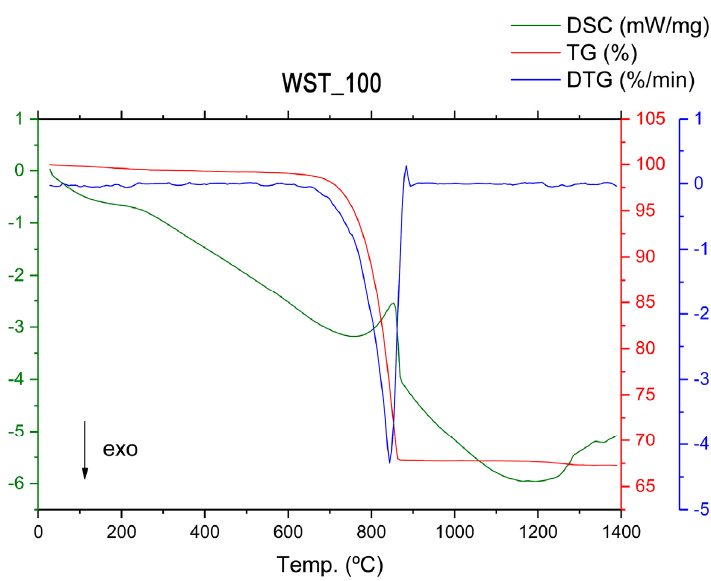
Figure 12. The TG (red line), DTG (blue line), and DSC (green line) analyses of crude-blend